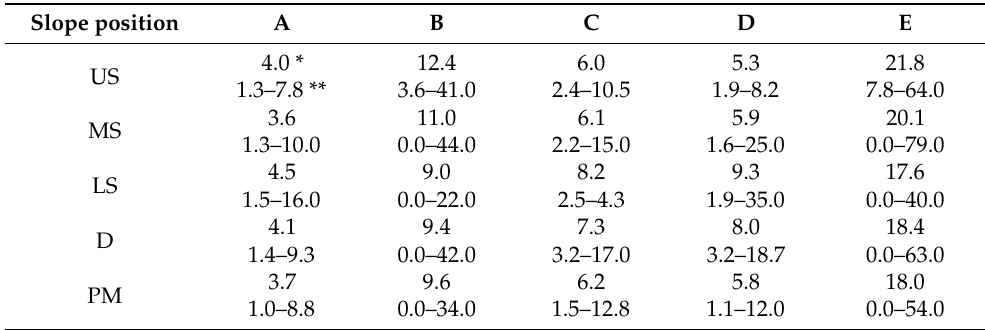
Table 7. Granulometric indices in humus horizons and parent materials in moraine landscape, regarding the soil position at the slope. Slope